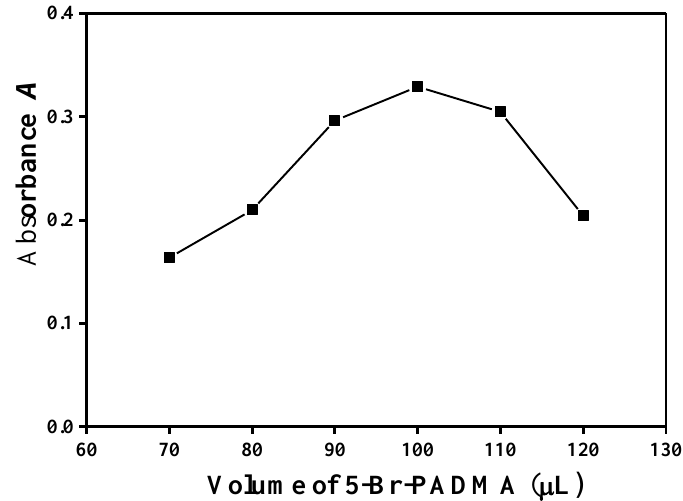
Figure 5. Effect of 5-Br-PADMA volume on the extraction efficiency of Cu(II). Extraction conditions: 5.00 mL water sample, pH = 5.0, 40 µL C 6 H 5 Cl, 500 µL CH 3 CN, and 0.5 ng Cu.